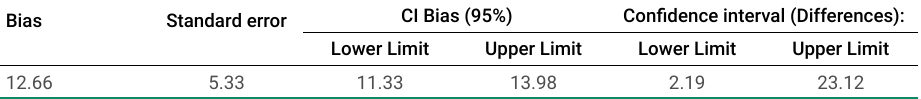
Table 3. Data received during Bland-Altman analysis of MFISS and FISS